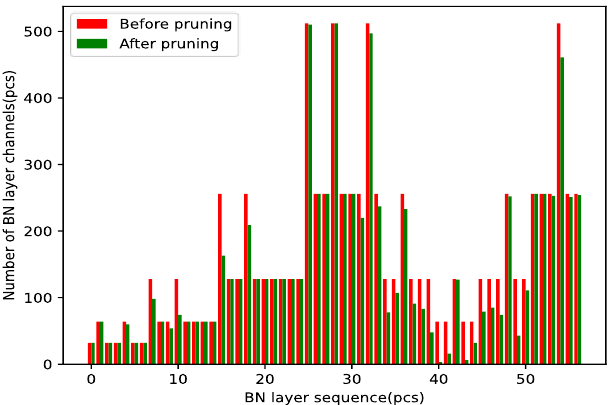
Figure 17. Change in the number of channels in the BN layer before and after pruning.